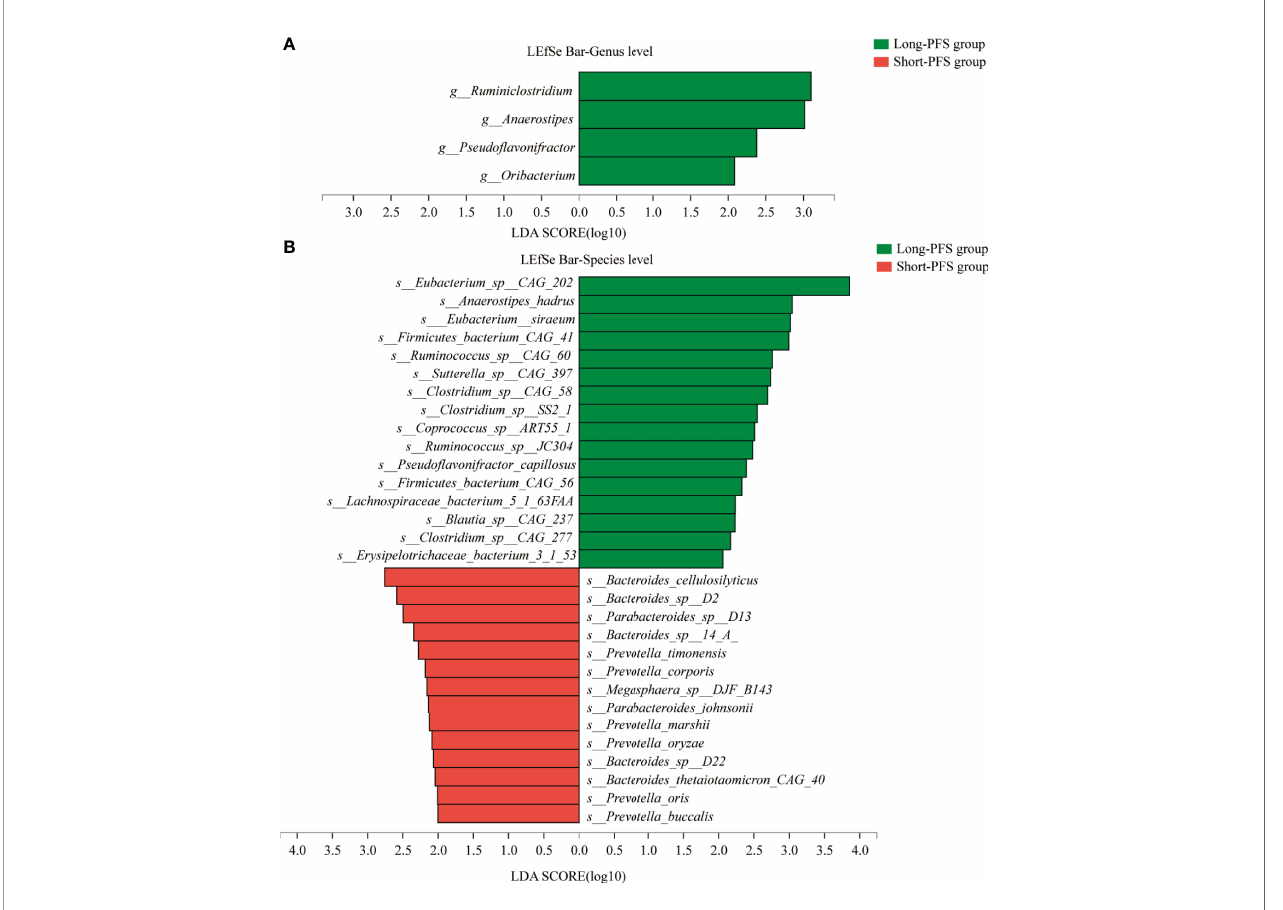
FIGURE 3 | The LEfSe analysis between short-PFS group and long-PFS group at genus level (A) and species level (B) ( Figure 4G ). Further analysis of functional metabolic pathway related to the KEGG pathway biosynthesis of vancomycin group antibiotics found that the dTDP-4-dehydro-6-deoxy-alpha-D- glucopyranose and 2,3-dehydratase were abundant in long-PFS group (p=0.35), while dTDP-glucose4,6-dehydratase was abundant in short-PFS group (p=0.35) ( Figure S2 ).